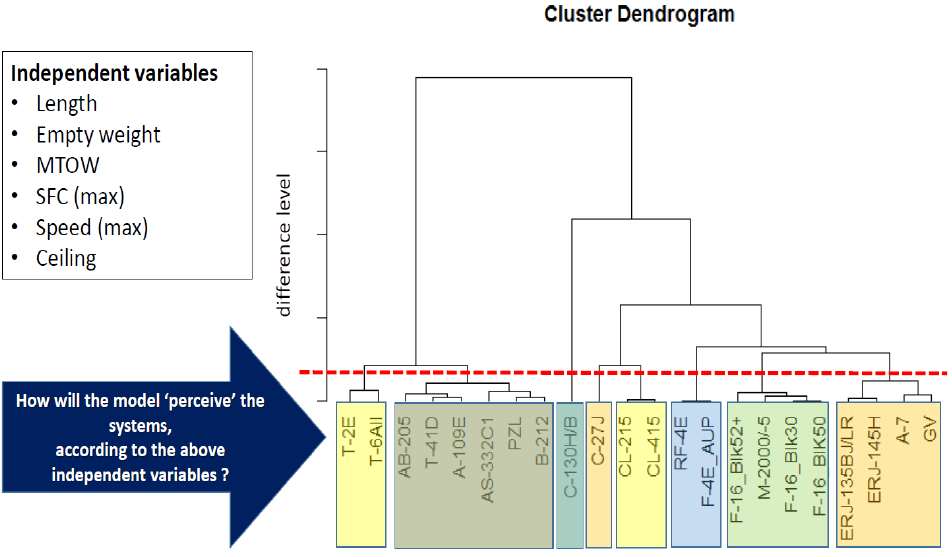
Figure 3. The cluster dendrogram of the 22 systems.